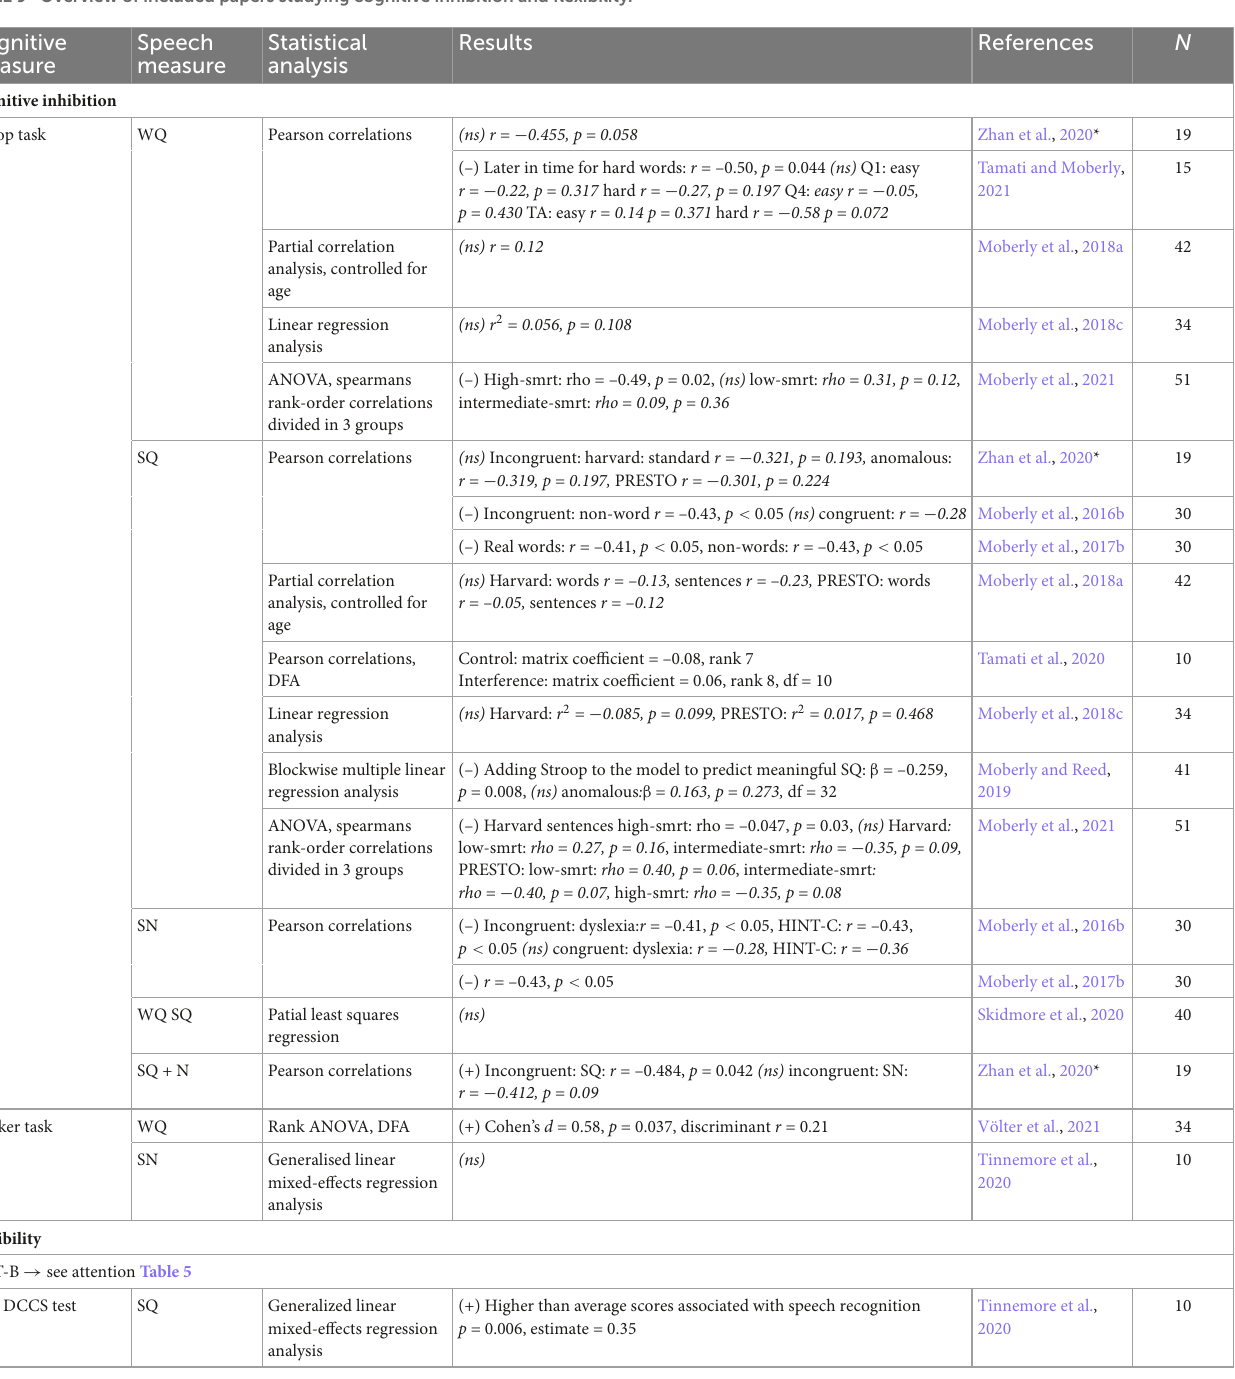
TABLE 9 Overview of included papers studying cognitive inhibition and